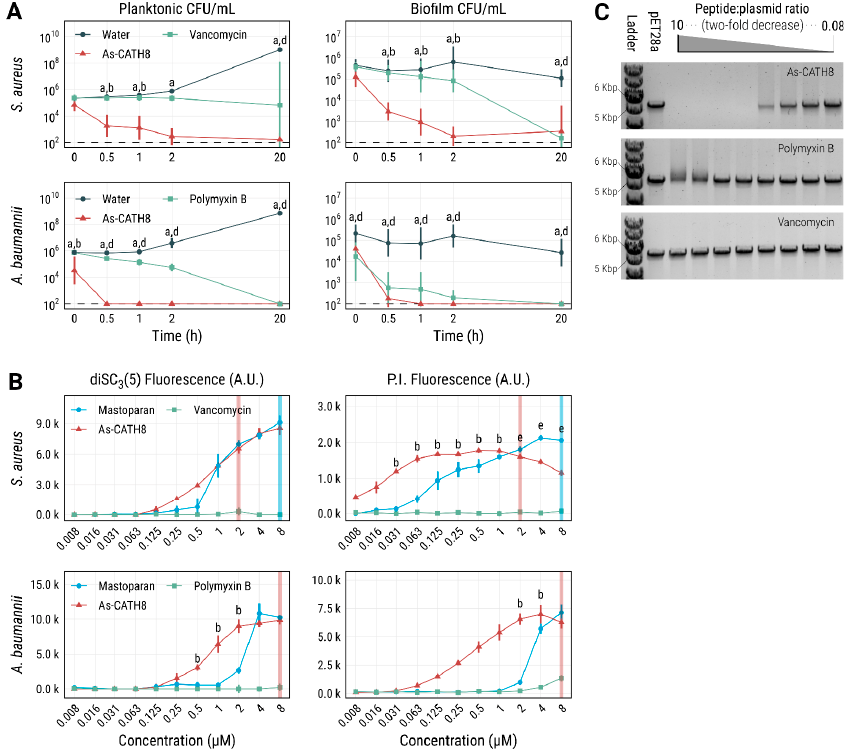
Figure 4. Bacterial killing rate, membrane depolarization and permeabilization and DNA binding capacity of As-CATH8. ( A ) Killing of planktonic S. aureus and A. baumannii cells at the MIC in MHB media. Antibiofilm activity was assessed in 10% TSB supplemented with 0.1% glucose at 64-fold MIC. CFU data are displayed as geometric mean ×/geometric standard deviation. ( B ) Cytoplasmic